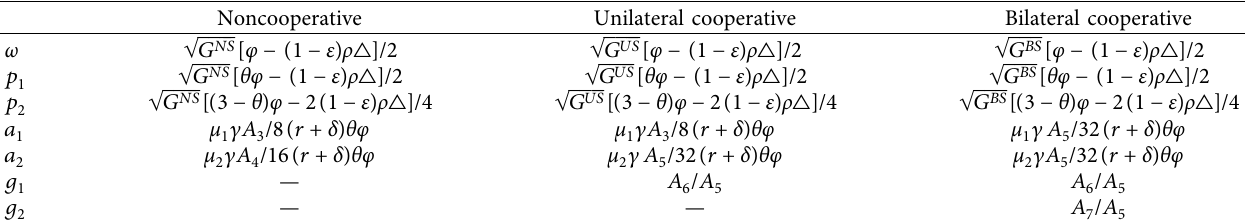
Table 6: The optimal solutions under a revenue-sharing